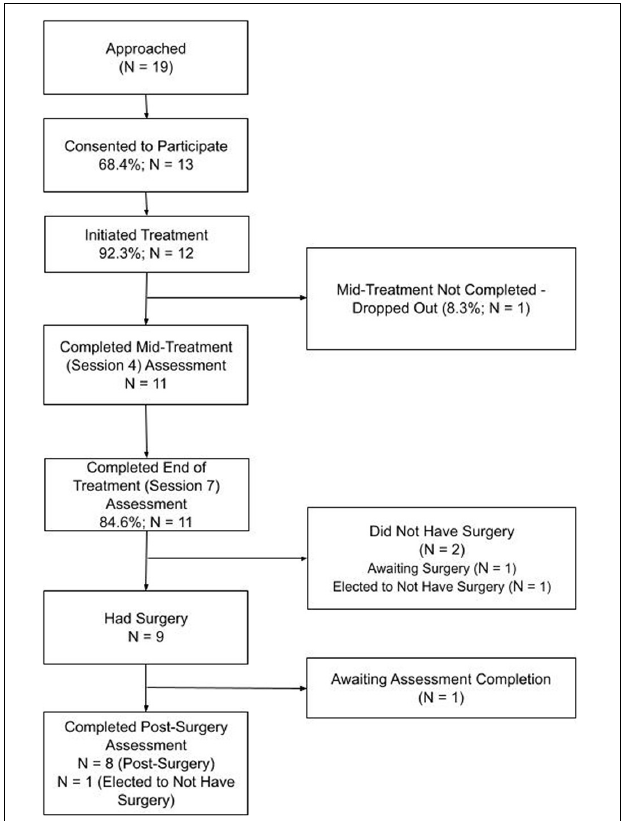
FIGURE 1 | Consort chart for feasibility trial, assessment completion defined by parent and/or child